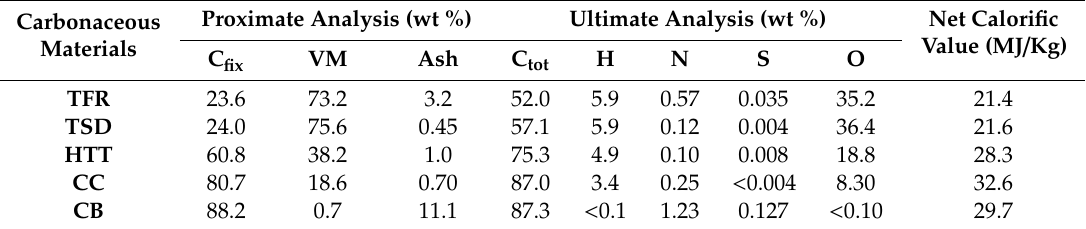
Table 2. Proximate and ultimate analysis results for carbonaceous materials (dry base).